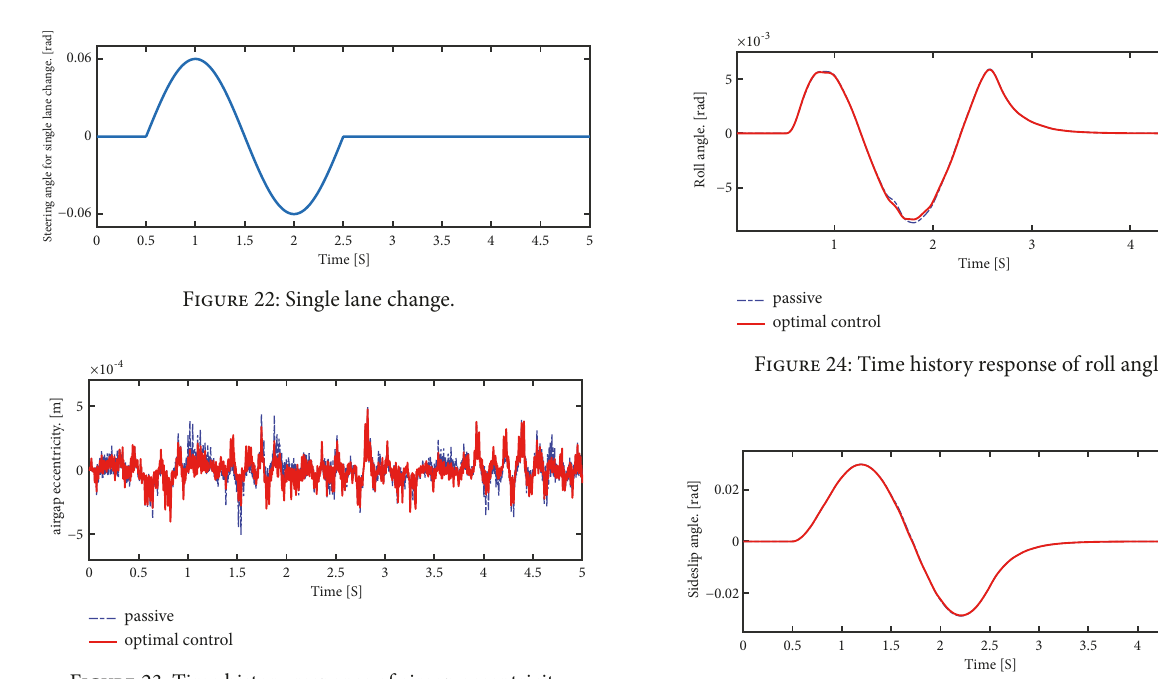
Figure 23: Time history response of airgap eccentricity.